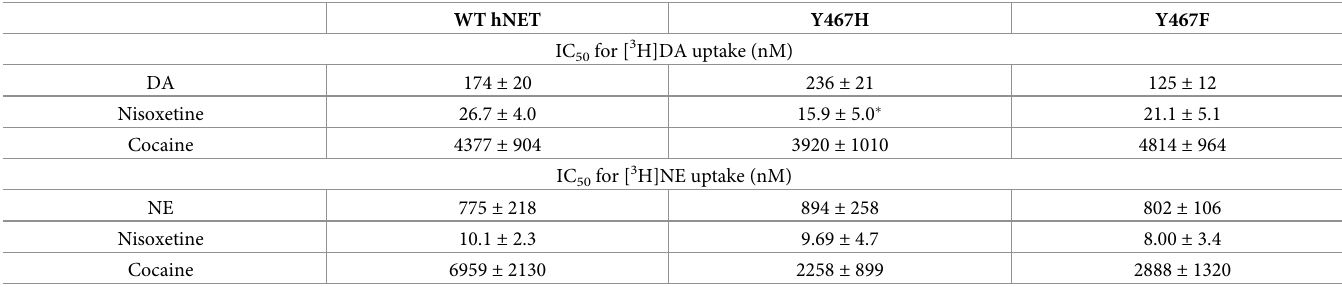
Data are presented as mean ± S.E.M. values from five to six independent experiments performed in duplicate. � p < 0.05, unpaired student’s t test compared to WT